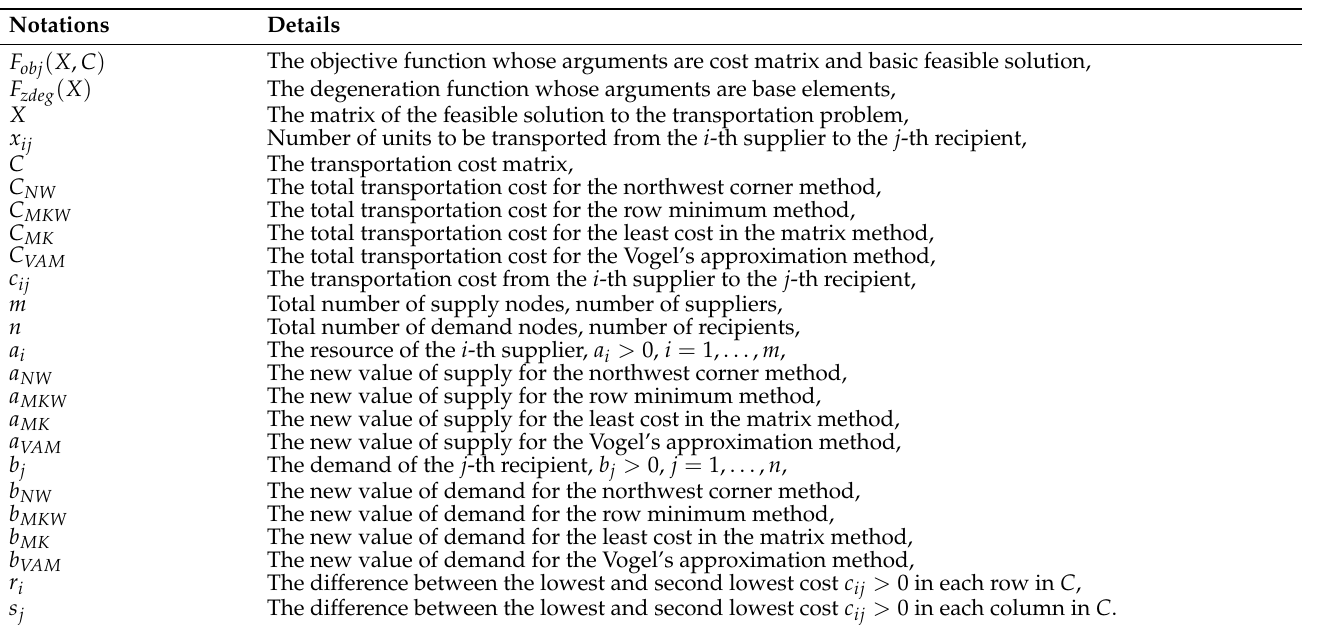
Table 2. List of